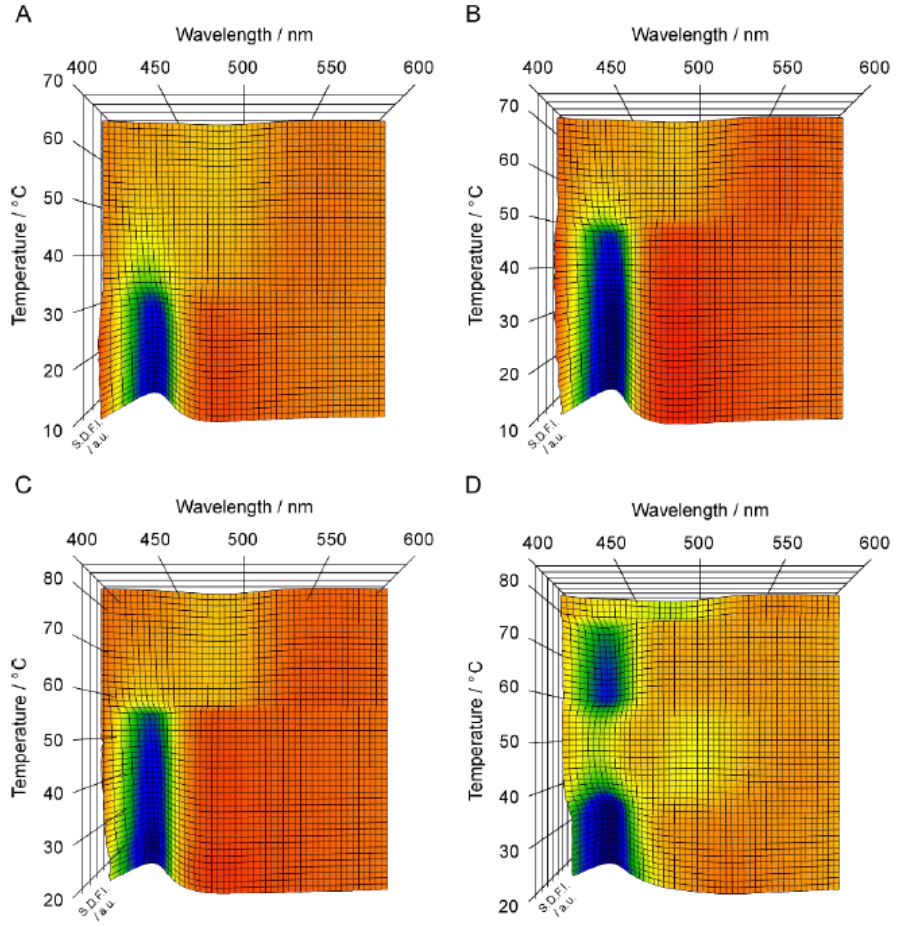
Figure 2. Spectral 3D imaging plots for C n PC bilayer membranes ( n = 12–15): ( A ) C12PC, ( B ) C13PC, ( C ) C14PC, ( D ) C15PC. The heating process along which the Prodan fluorescence spectro ‐ scopic observation was carried out to construct each 3D imaging plot is given as an arrow shown in Figure 3.